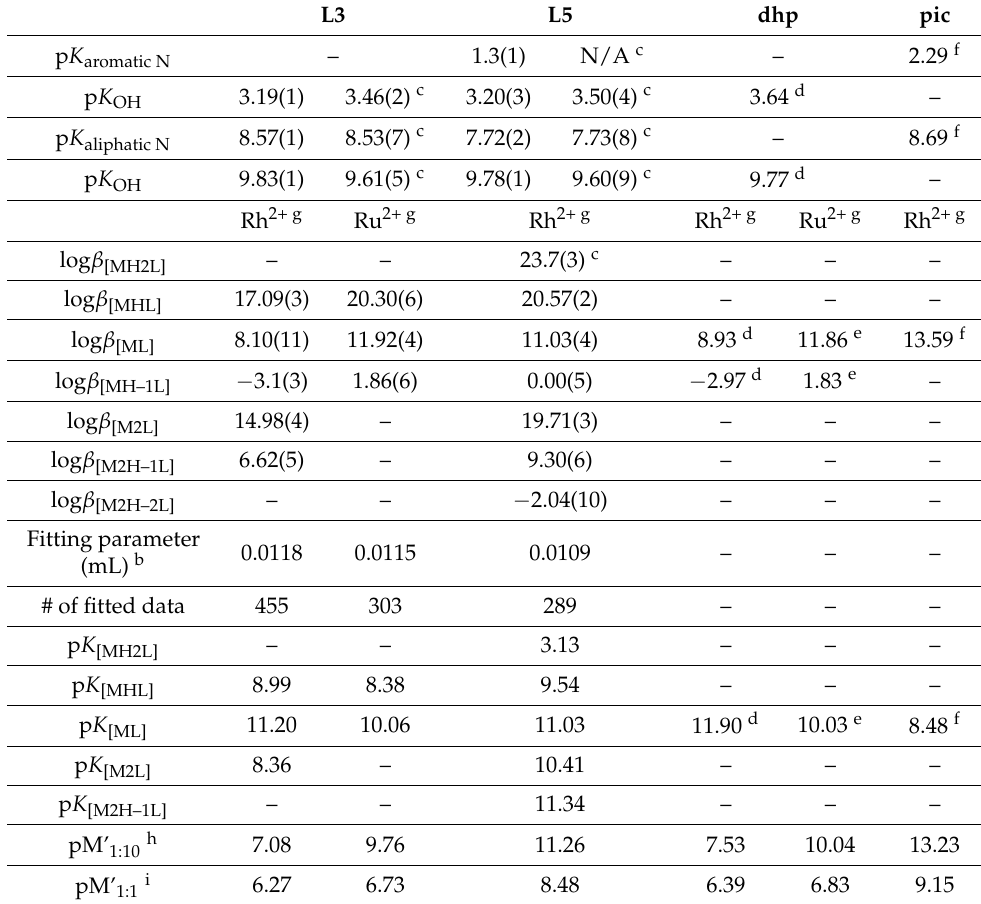
Table 1. Dissociation constants (p K ) of the ligands, overall stability constants (log β ), and some derived constants of their [( η 5 -Cp*)Rh] 2+ and [ η 6 - p -cym)Ru] 2+ complexes at 25.0 ◦ C and I = 0.20 M KCl a . L3